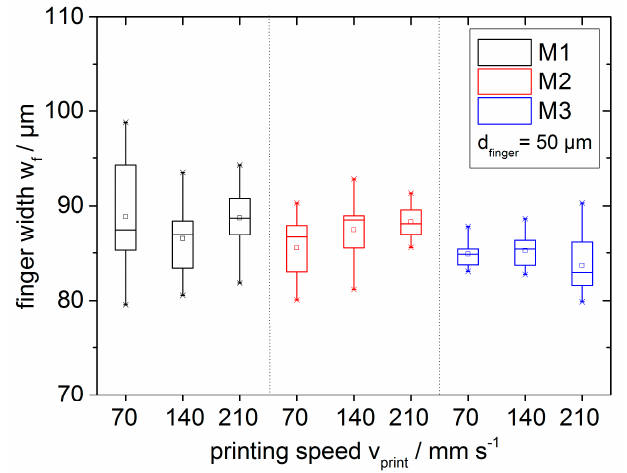
Figure 8. Resulting finger widths w f printed through a 50 µm finger opening are plotted versus printing speed v print (70, 140, and 210 mm s − 1 ) for model silver pastes M1, M2, and M3.